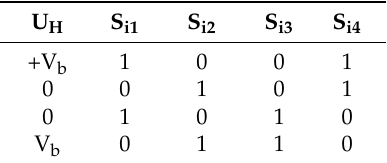
Table 2. Switches’ state of different output voltages.